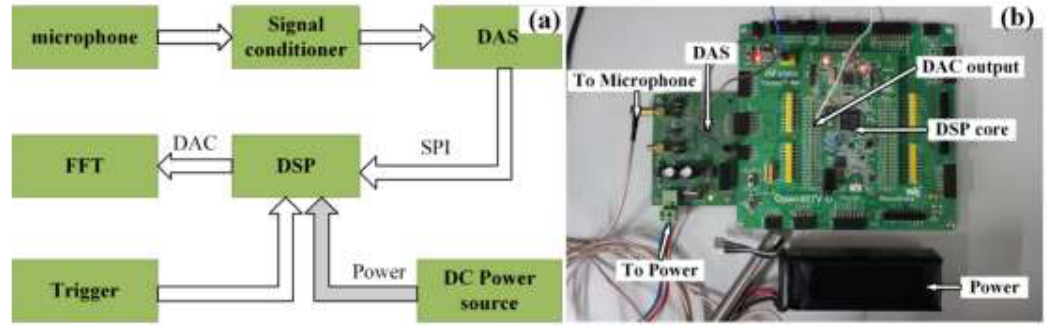
Figure 12. ( a ) The module diagram of the designed embedded system; ( b ) the hardware details of the embedded